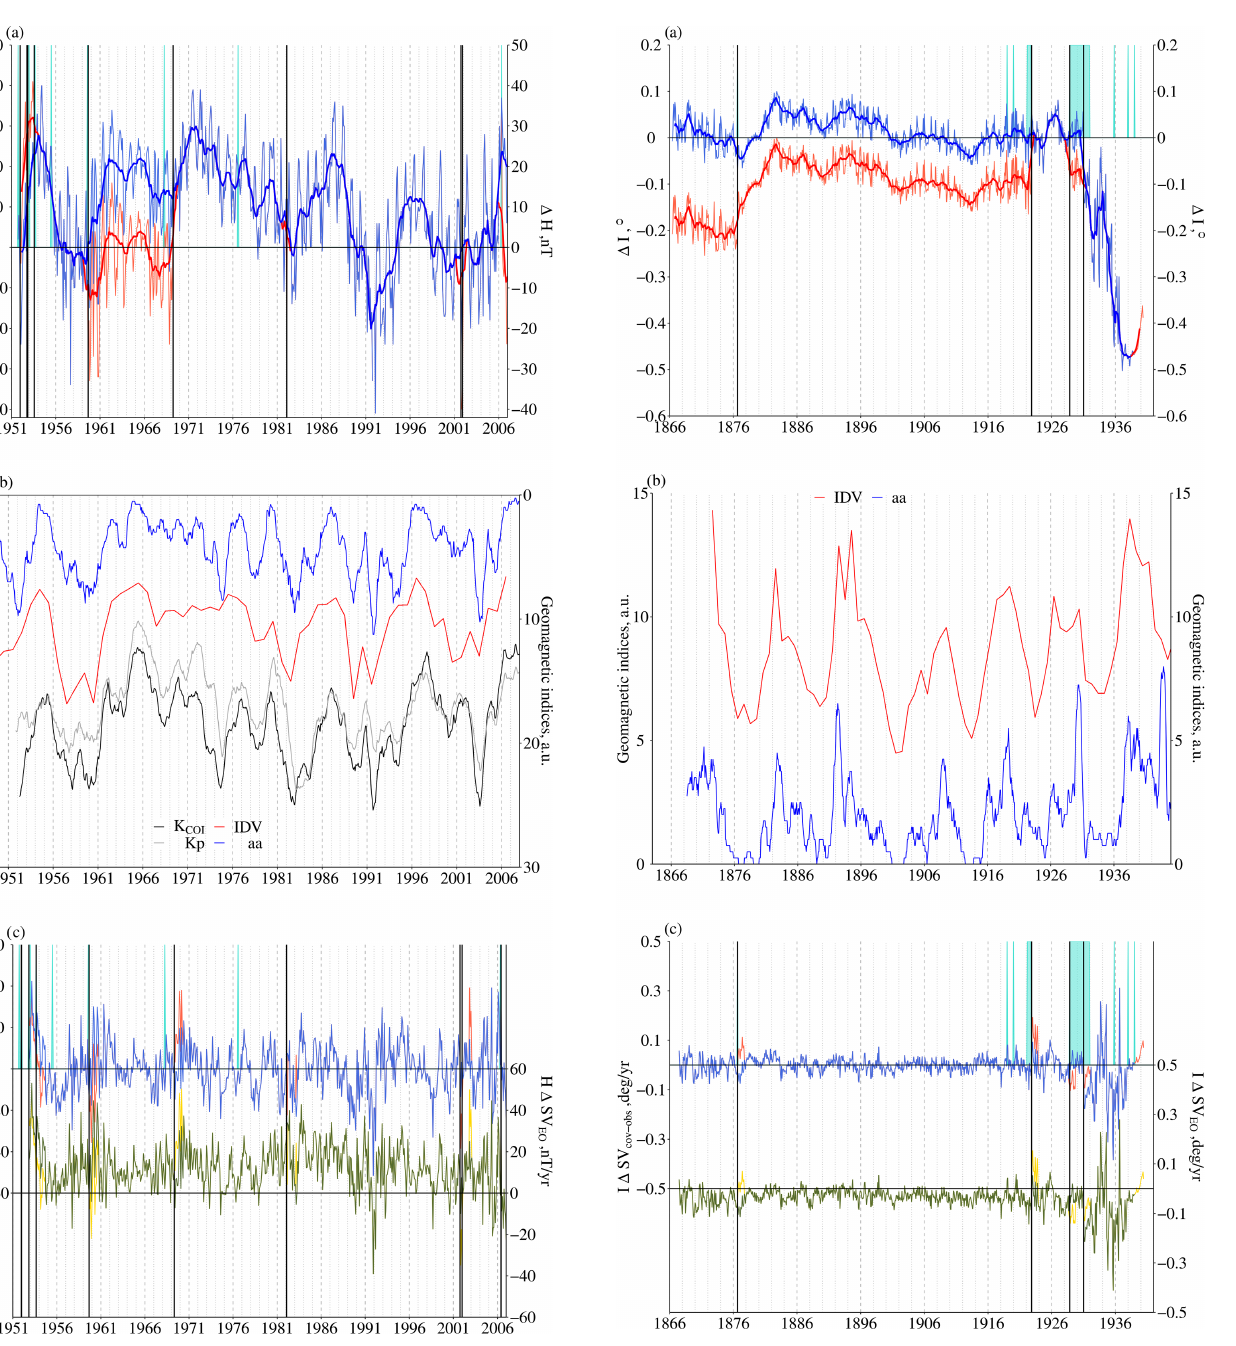
Figure 3. Same as Fig. 2 but for the AdB period of measurements: 1951–2006. On (b) the monthly sums of the local K COI (grey) and the global Kp (black) indices are also shown.